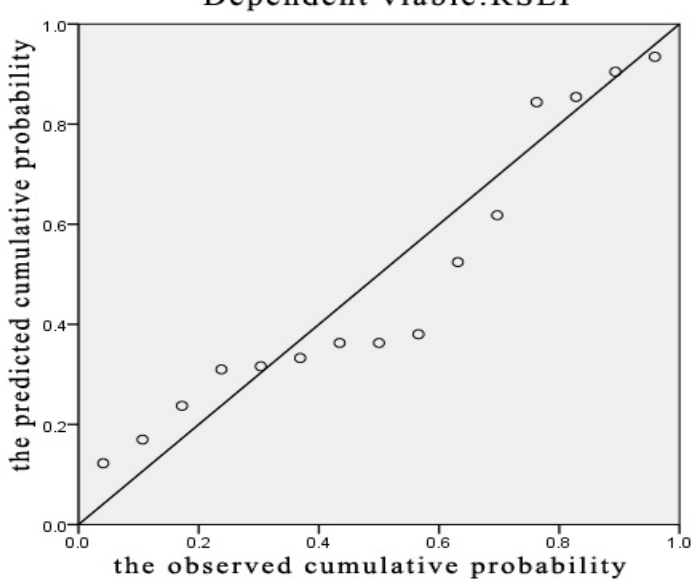
Figure 5. P-P plot of regression standardized residuals.